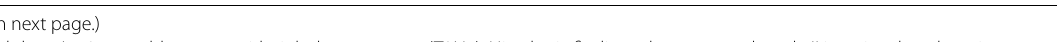
Bold means the parameter was significant p -value < 0.05